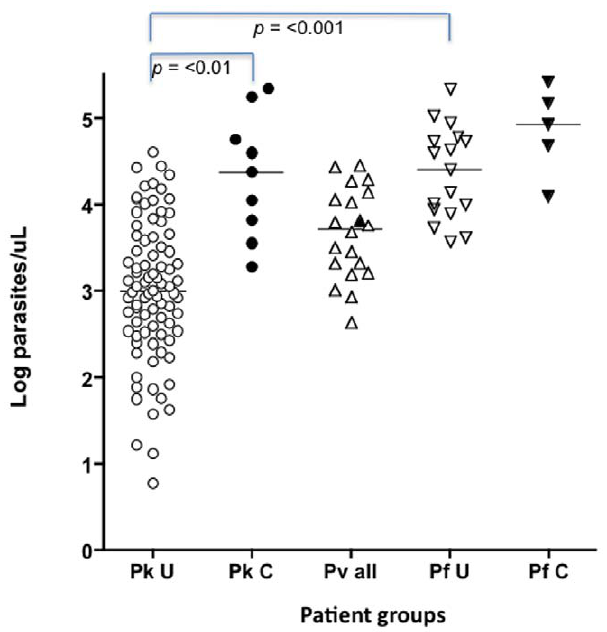
Figure 1. Differences in parasitaemia between species. Pk = P. knowlesi , Pv =P. vivax and Pf = P. falciparum . U= patients with uncomplicated disease and C= patients with complicated. The point corresponding the P. vivax patient with complicated disease is shaded. The Kruskal-Wallis test was significant ( p = , 0.0001) for between group differences. Dunn’s post test values are shown when p = , 0.05.